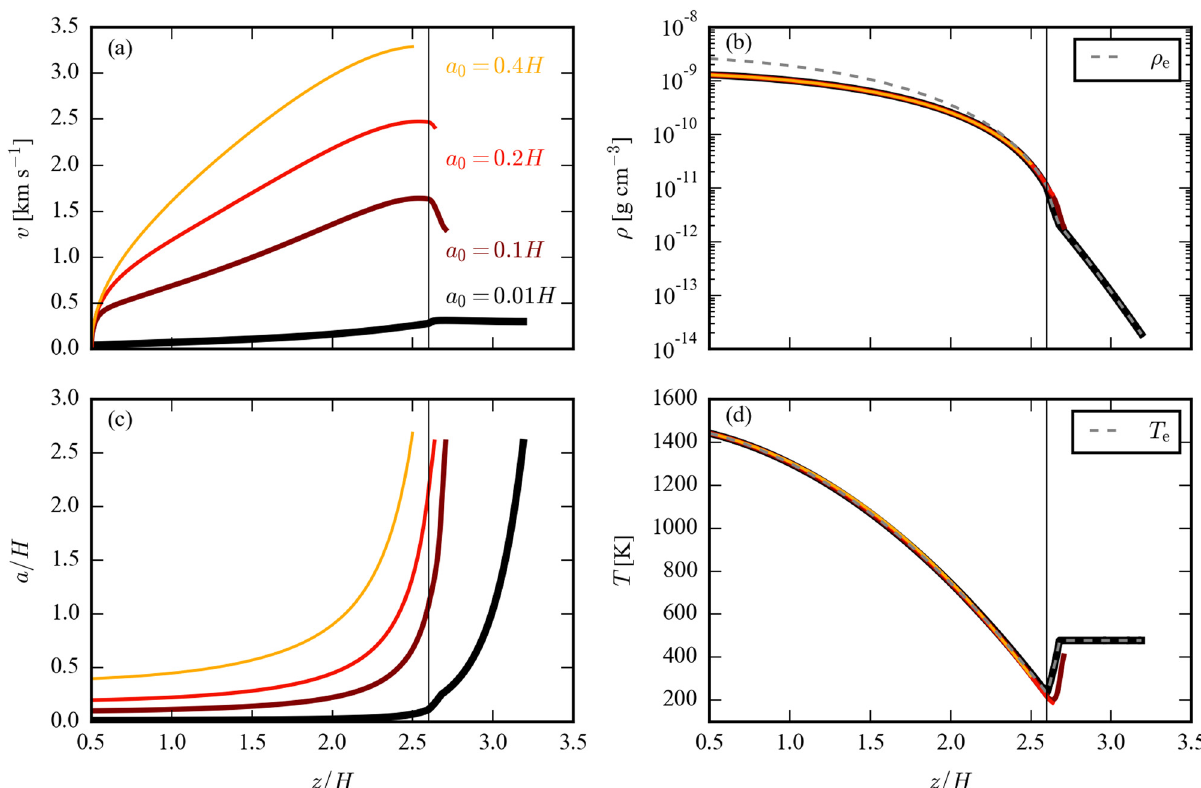
Figure 2: Dynamics of the MFTs of various initial cross - section radii a 0 in the absence of the external magnetic fi eld. Dependences of the MFT ’ s speed ( panel a ) , density ( b ) , cross - section radius ( c ) , and temperature ( d ) on the z - coordinate are shown. Vertical lines show the surface of the disk. Grey dashed lines in panels ( b ) and ( d ) delineate the corresponding pro fi les of the disk ’ s density and temperature. Initial parameters of the MFT: r 0.5 au